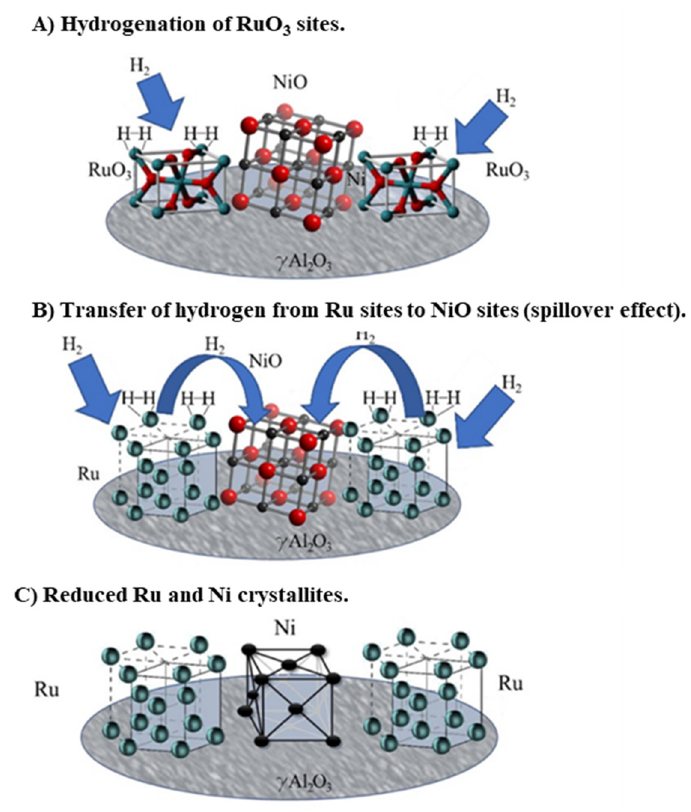
Figure 3. Schematic description of the spillover effect of H 2 on the Ru–Ni surface catalyst. ( A ) H 2 chemisorbs on RuO 3, forming Ru crystallites, ( B ) H 2 chemisorbed on Ru migrates to the NiO sites, ( C ) Reduced Ru and Ni crystallites are ready for gasification.